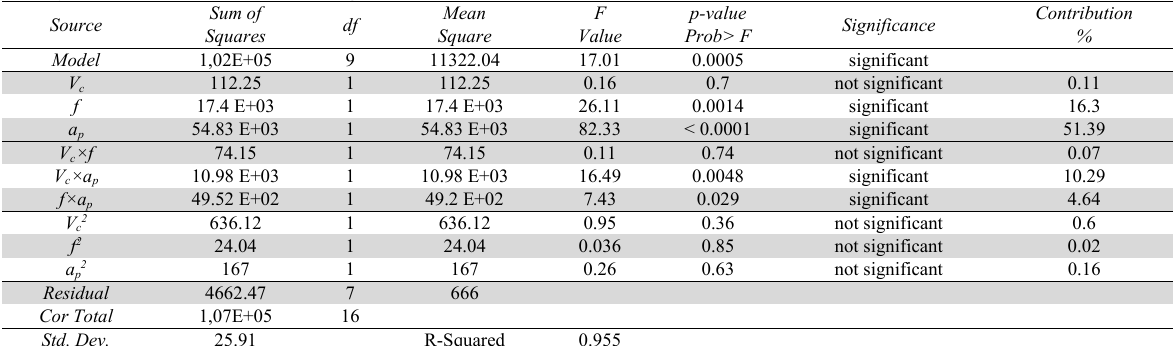
Analysis of variance for cutting force Source